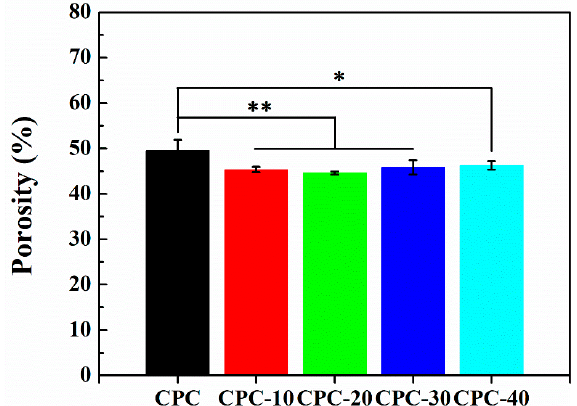
Figure 7. The porosity of CPC and PLGA-PEG-PLGA/CPCs after immersion for three days (n = 5, ** p < 0.001, * p < 0.05).